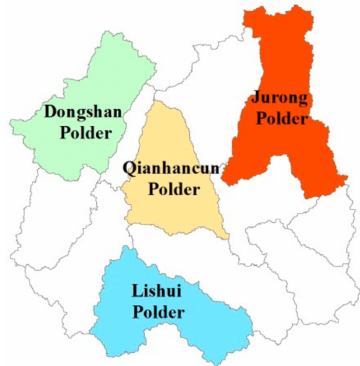
Figure 2. The urban aggregation polders in the Qinhuai River